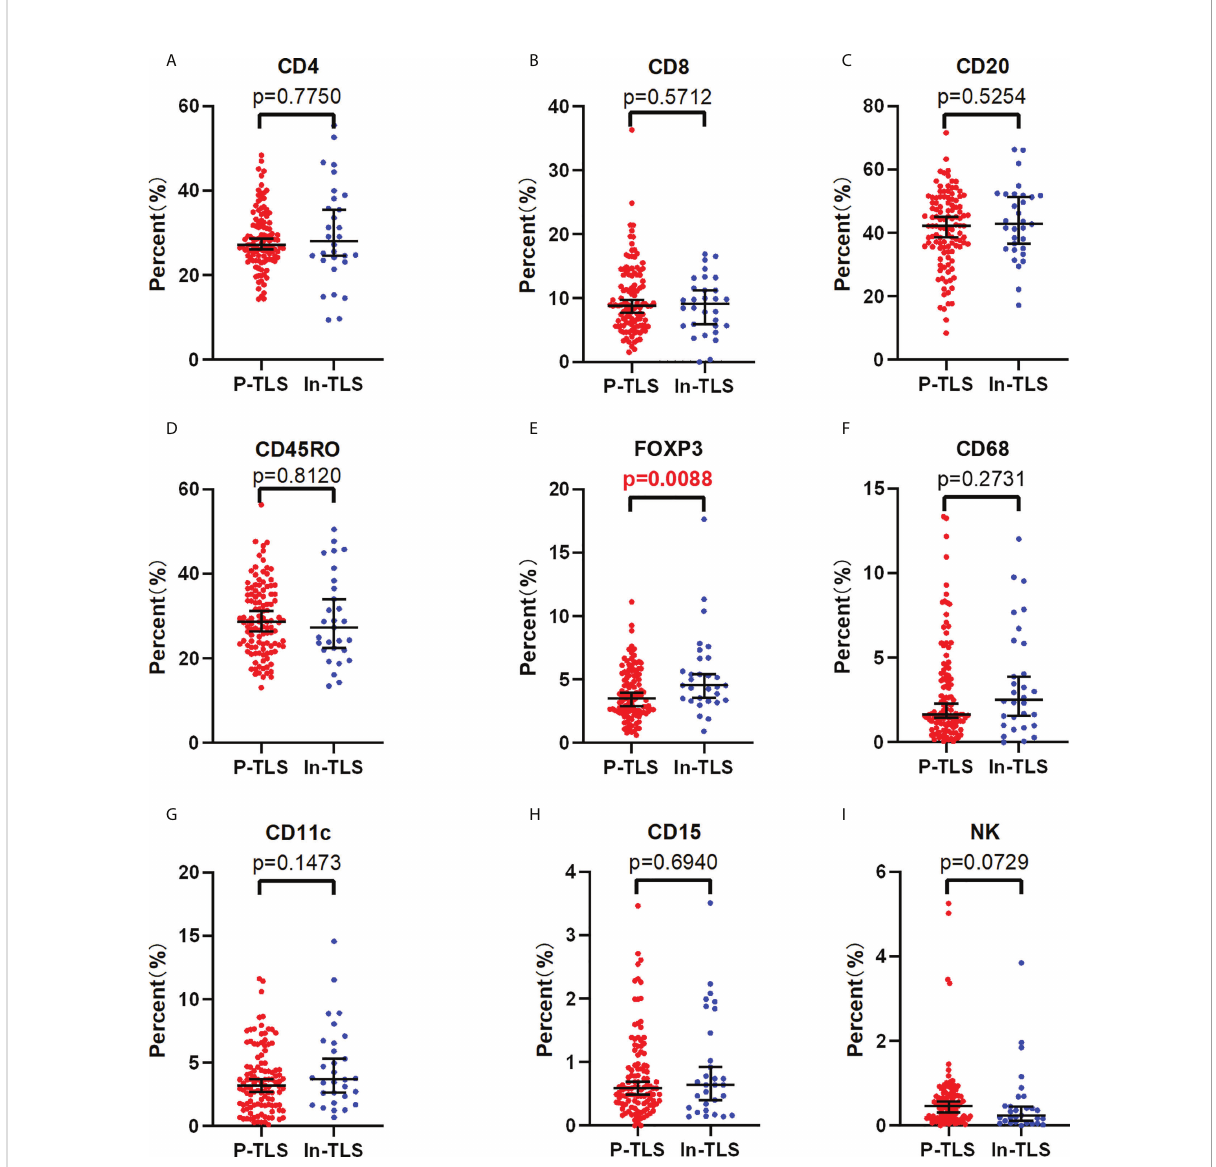
FIGURE 5 The difference between the P-TLS-cellular components and In-TLS-cellular components. (A) CD4+T cells; (B) CD8+T cells; (C) CD20+ B cells; (D) CD45RO+ lymphocytes; (E) FOXP3+Tregs; (F) CD68+TAMs; (G) CD11c+DC cells; (H) CD15+ TANs; (I) NCR1+NK